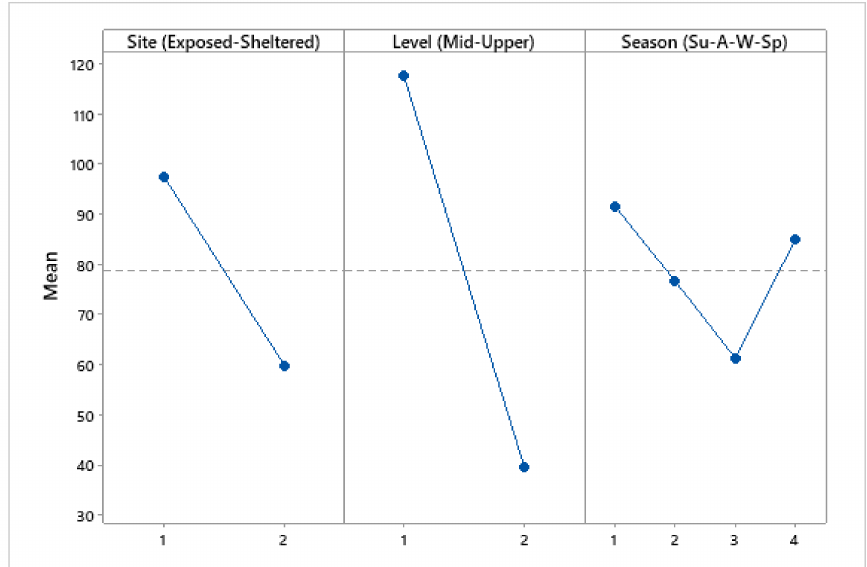
Figure 9. Main e ff ects plot of the influence of each factor (sampling site, shore level, and season) on the mean C. stellatus population density.